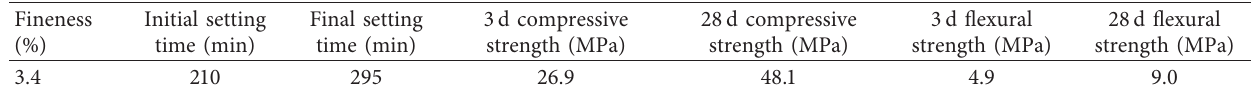
Table 2: Physical and mechanical properties of PO 32.5 composite Portland cement.